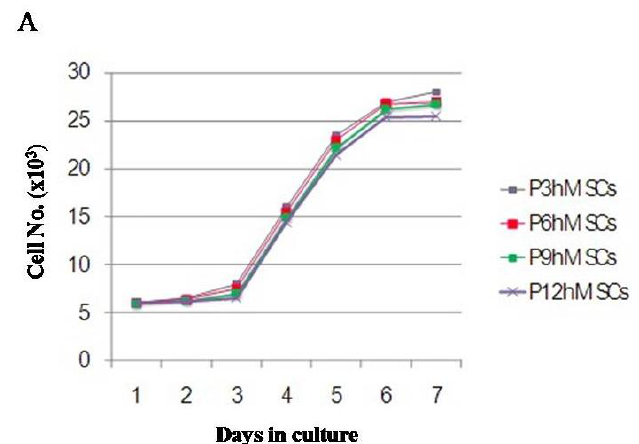
Figure 3. The growth cures and adipogenic, osteogenic differentiation of hMSCs. ( A ) Isolated hMSCs (8 × 10 3 ) were seeded into a 24-well plate in DMEM supplemented with 10% FBS for a total of 7 days. The cell number on each day was determined with trypan blue staining; ( B ) The isolated hMSCs underwent osteogenic and adipogenic differentiation for different time periods. The cell morphology, ALP and oil red O stain were examined by differential interference contrast microscopy respectively. Scale bar, 100